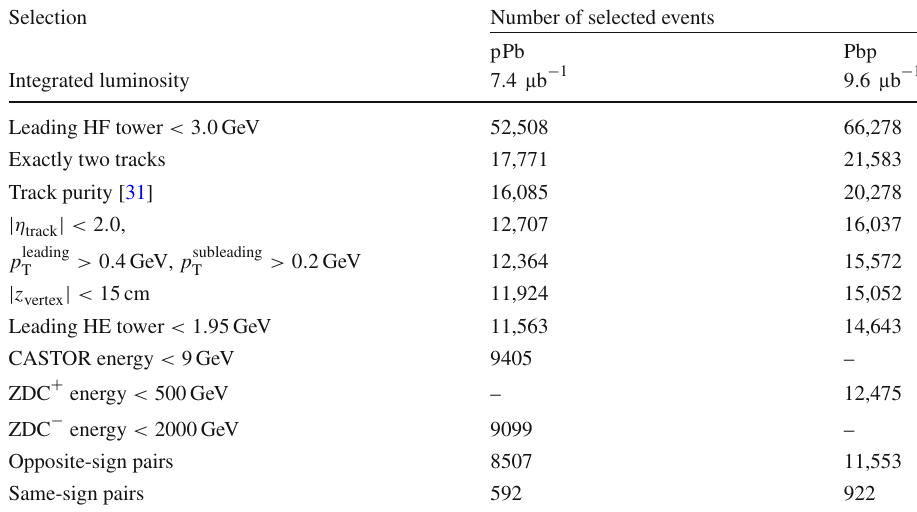
Table 1 Integrated luminosity and number of events after each of the selection requirements for the two data samples. The leading tower is the tower with the largest energy deposition in the